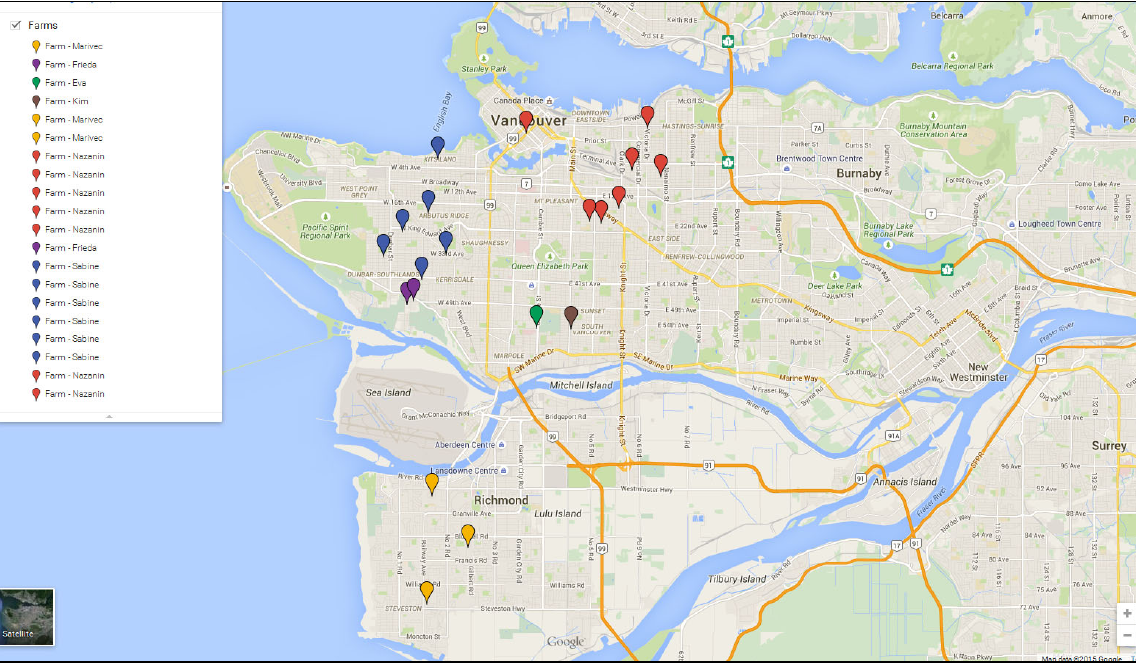
Figure 2. Urban Farm Sites in Metropolitan Vancouver (pins indicate approximate